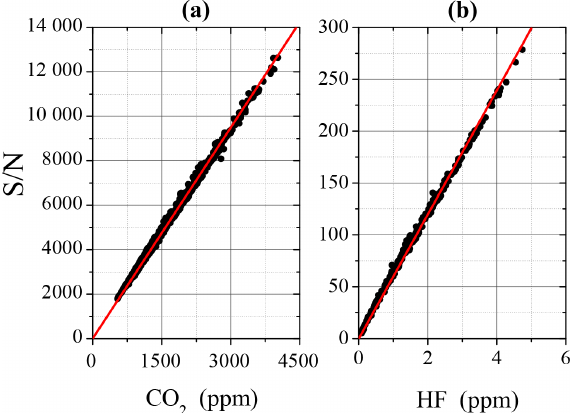
Figure 10. Signal-to-noise ratio ( S/N ) as a function of CO 2 mix- ing ratio (a) and HF mixing ratio (b) for 13min of measurement in proximity to a fumarole of the Vulcano volcano on 20 May 2015. The red line is the result of a linear fit. The measurement was car- ried out in the open-cell configuration at a pressure of 990mbar and at a temperature variable between 310 and